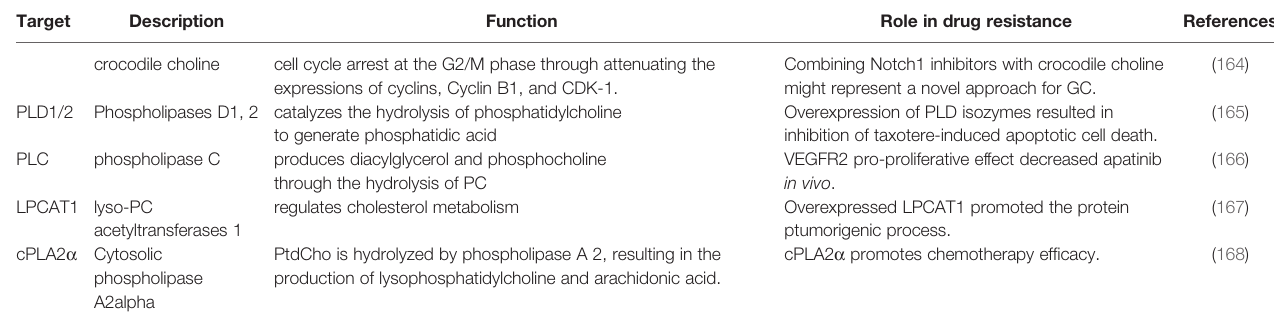
TABLE 2 | Summary of targeting phosphatidylcholine metabolism for drug